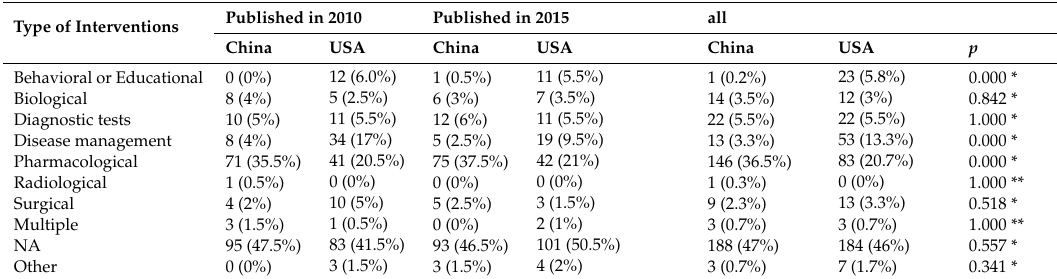
Table 3. Interventions evaluated in the included studies.